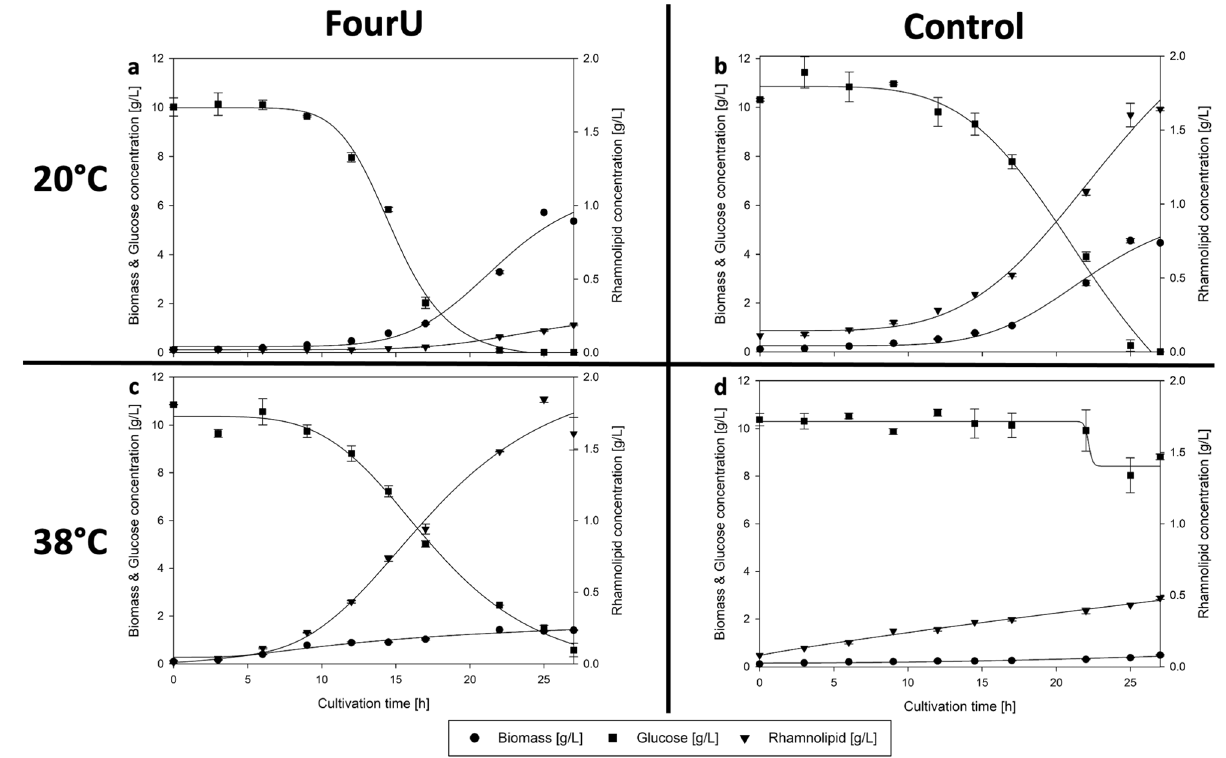
Figure 2. Time course of biomass- (circles), rhamnolipid- (triangles) and glucose concentration (squares) during shake flask cultivation of P. putida KT2440 pSynPro8oT_4U_ rhlAB and pSynPro8oT_4U(G14A-